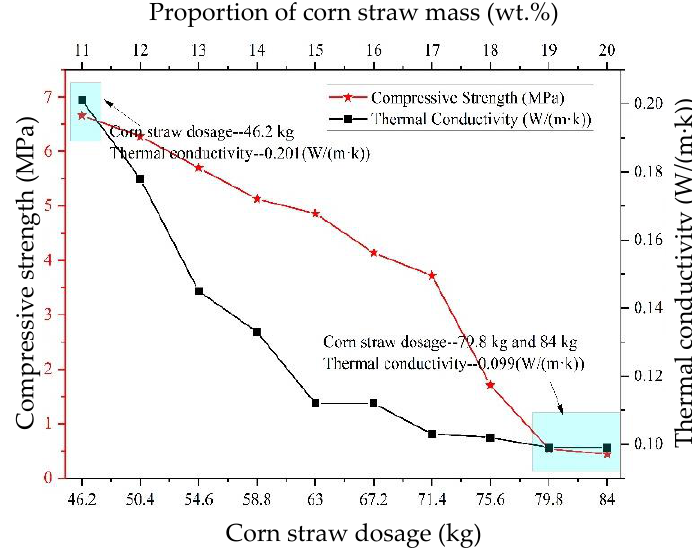
Figure 9. Effect of corn straw content on CSCC.